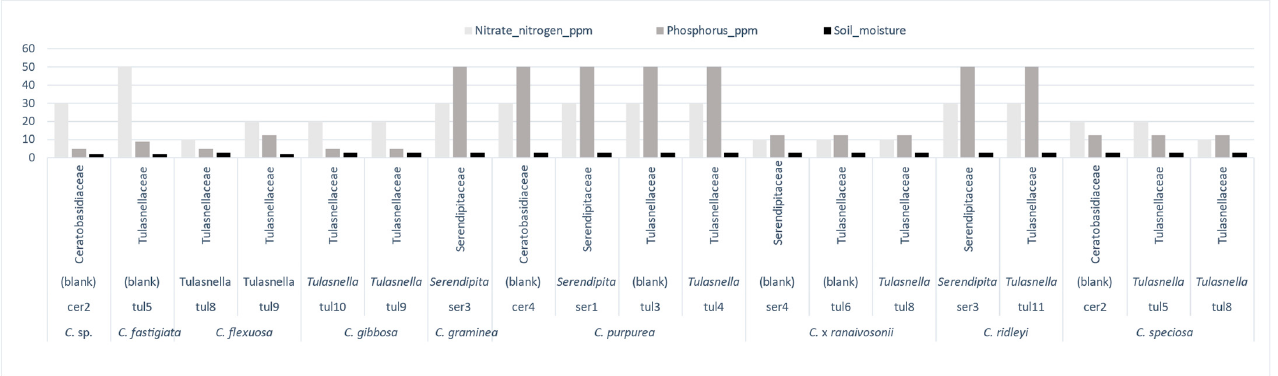
Figure 6. ( A – C ) Pearson correlation heatmaps showing the relationship between diversity indices (Shannon’s— H, Simpson’s— D) and soil parameters (pH, NO 3- N, P, and K).